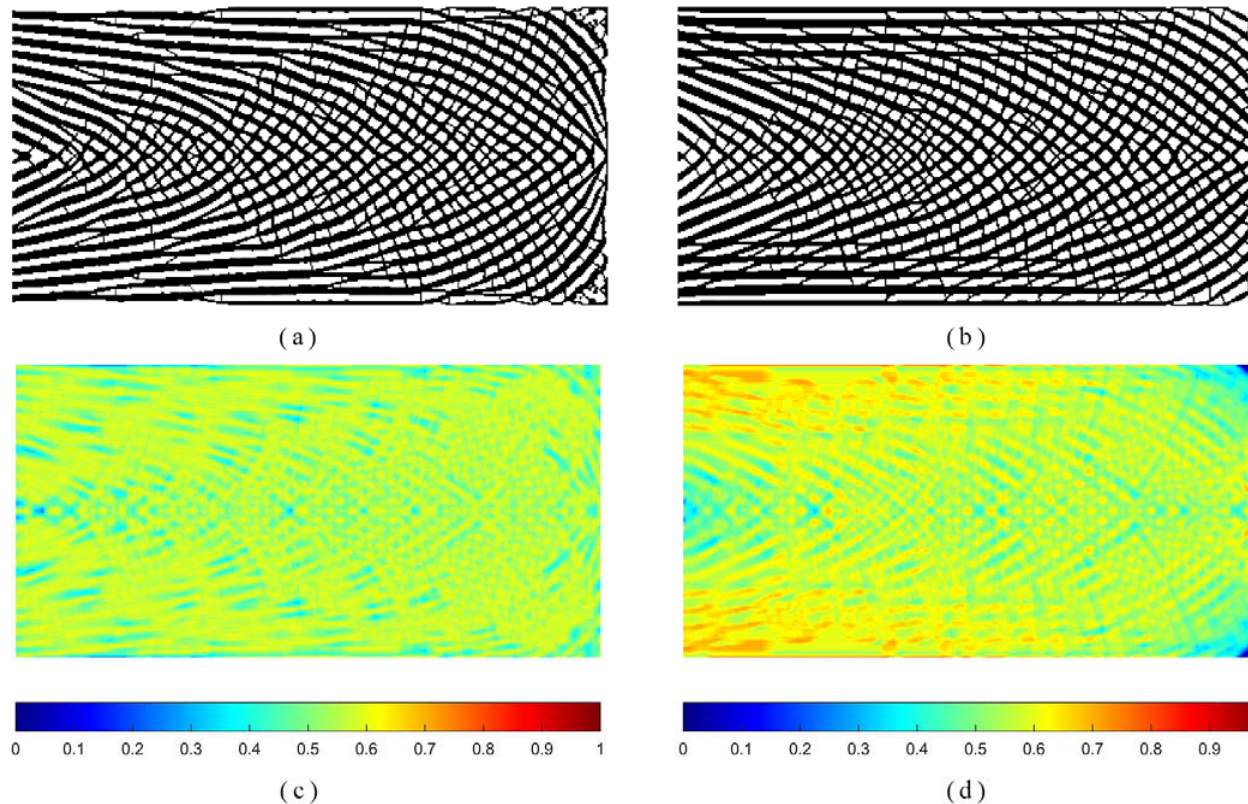
Figure 2. The optimized topologies obtained from: ( a ) the proposed method: c = 85.780, V f = 0.546; ( b ) c = 75.184, V f = 0.564 as well as the Local volume fraction distribution from: ( c ) the proposed method: max (cid:0) (cid:1) = max ρ e